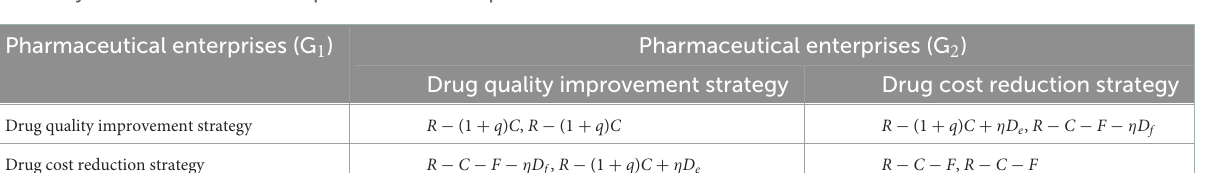
TABLE 3 Symmetrical returns matrix of pharmaceutical